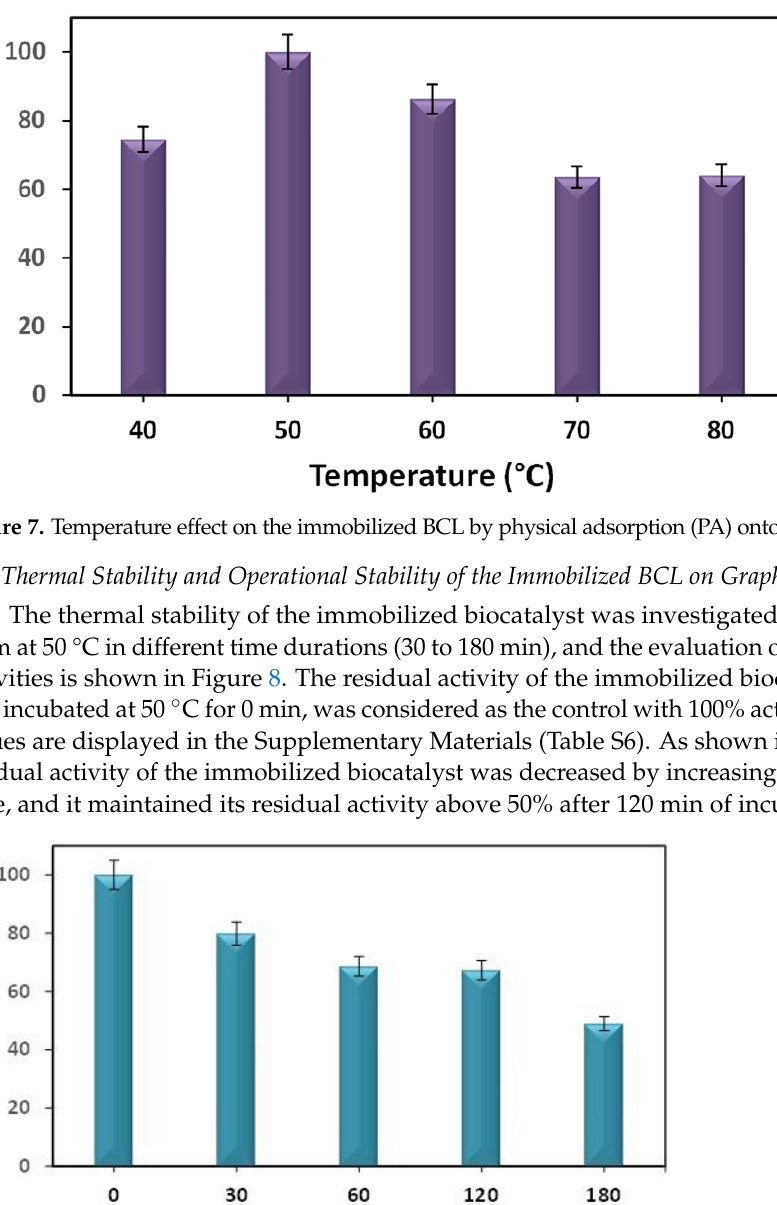
Figure 8. Thermal stability of the immobilized biocatalyst incubated at 50°C.